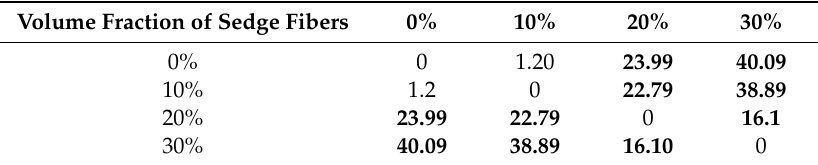
Table 3. HSD (honestly significant di ff erence) test for the Izod impact energy of the neat epoxy resin and CM sedge fiber-reinforced